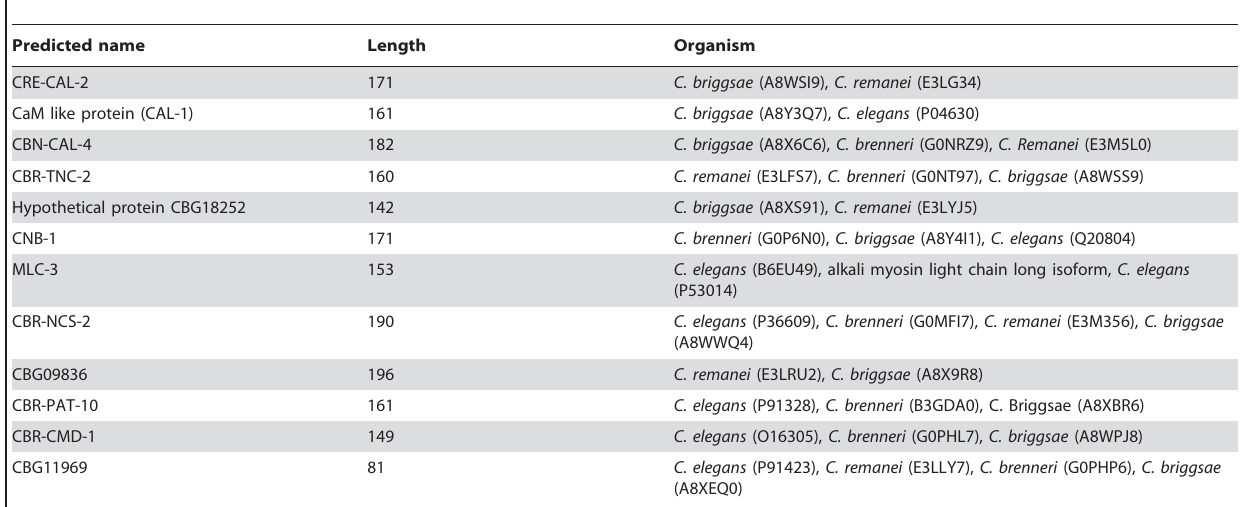
Table S1 lists other domains found in the EF-hand containing protein. In these EF hand proteins position of the EF hand is not Table 4. Occurrence of EF-hand proteins in more than one Caenorhabditis